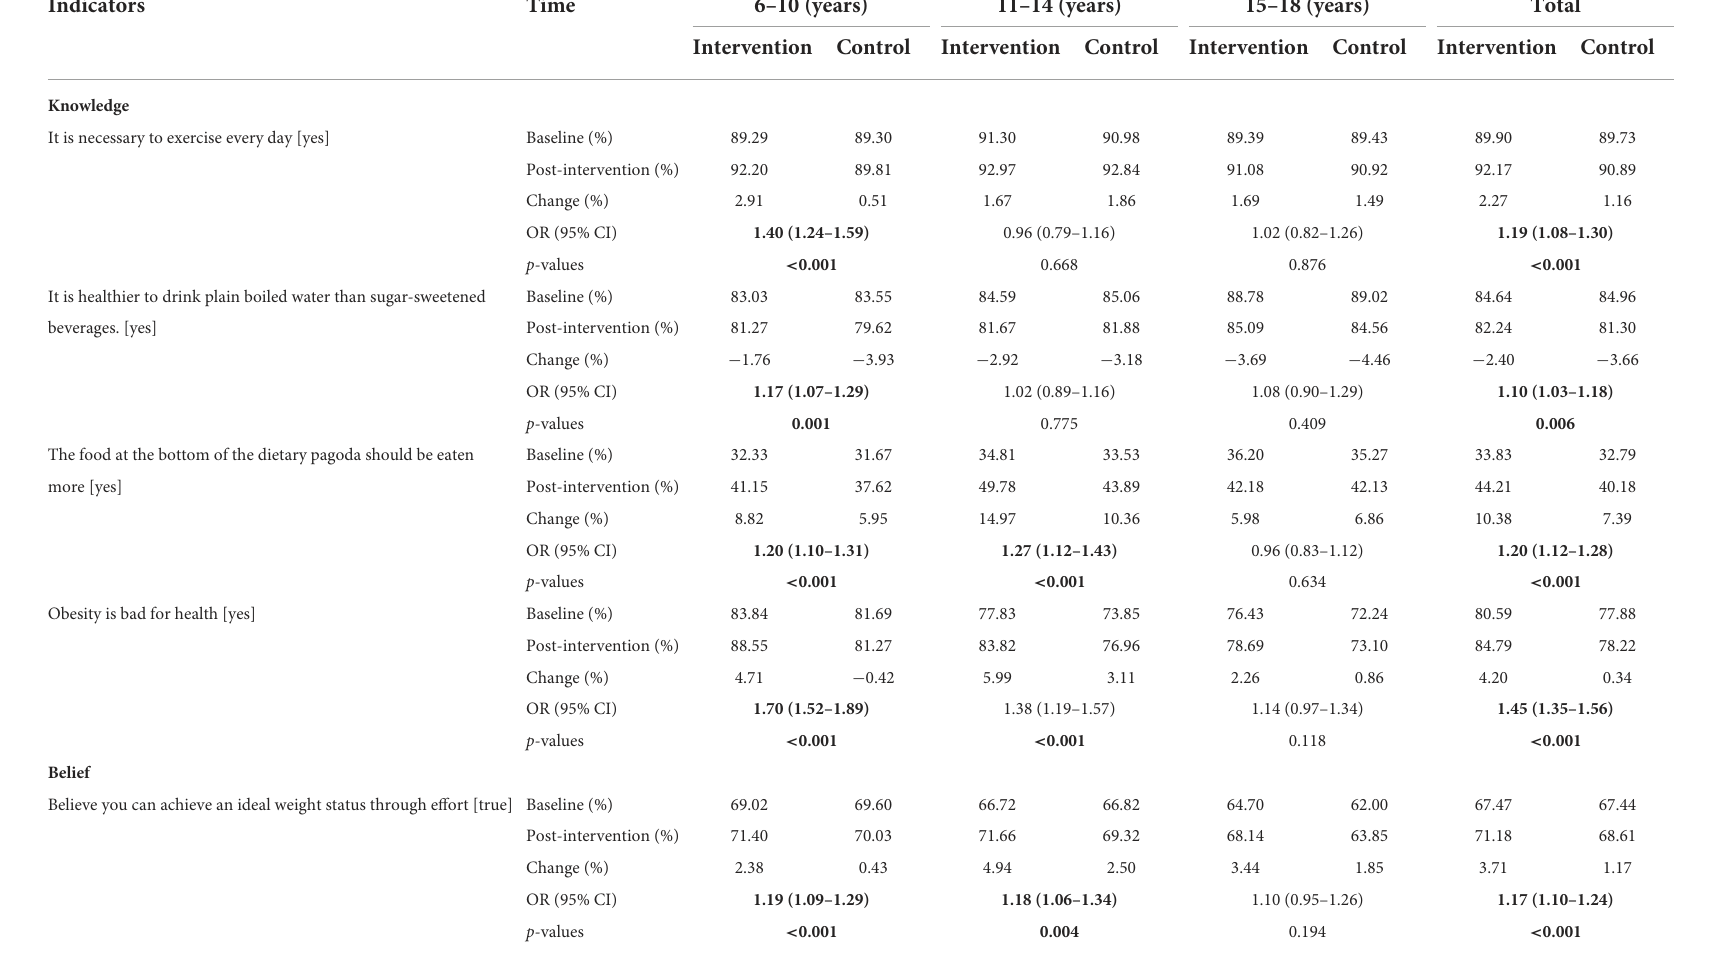
TABLE 3 Effectiveness on the student’s knowledge, belief, and practice (by